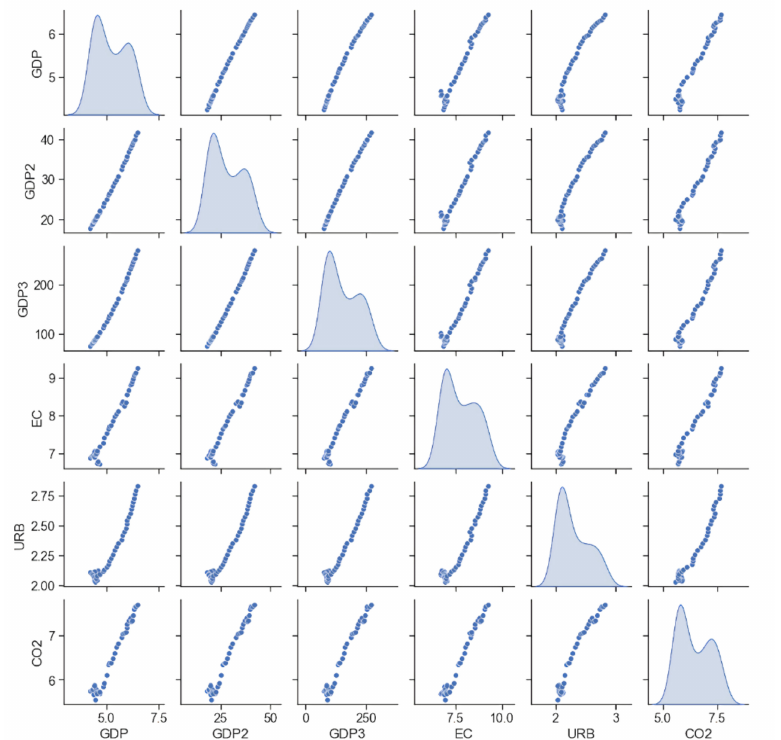
Figure A5. The illustration of the correlation between each pair of analyzed variables and the distribution of each